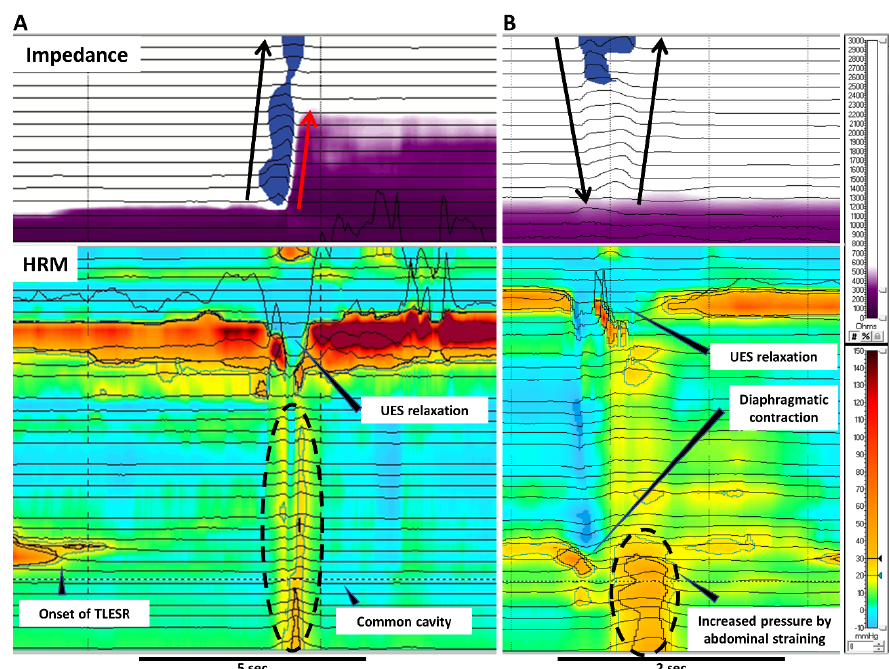
Figure 2. Gastric belching and supragastric belching in HRM combined with impedance. These pictures illustrate GB ( A ) and SGB ( B ) in simultaneous recording of impedance and HRM. ( A ) A GB occurs with liquid reflux during TLESR. GB can be recognized as a common cavity in HRM. The air evacuates from the stomach to the pharynx through the relaxed UES. ( B ) In SGB, the contraction of the diaphragm generates negative pressure in the esophagus. UES relaxation lets air into the esophagus followed by expelling the air by abdominal straining. No peristalsis is involved with the air movement in SGB. Black arrows indicate the movement of air whereas red arrows indicate liquid reflux. HRM; high resolution manometry, TLESR; transient lower esophageal sphincter relaxation, UES; upper esophageal sphincter.